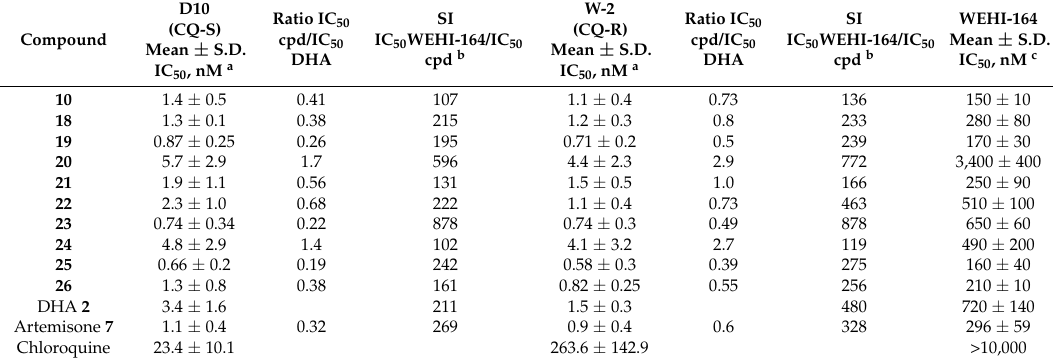
Table 1. In vitro screening of the N -glycosylated DHA piperazine derivatives against P. falciparum CQ-sensitive D10 and CQ-resistant W2 strains, and cytotoxicity on the mouse fibroblast cell line